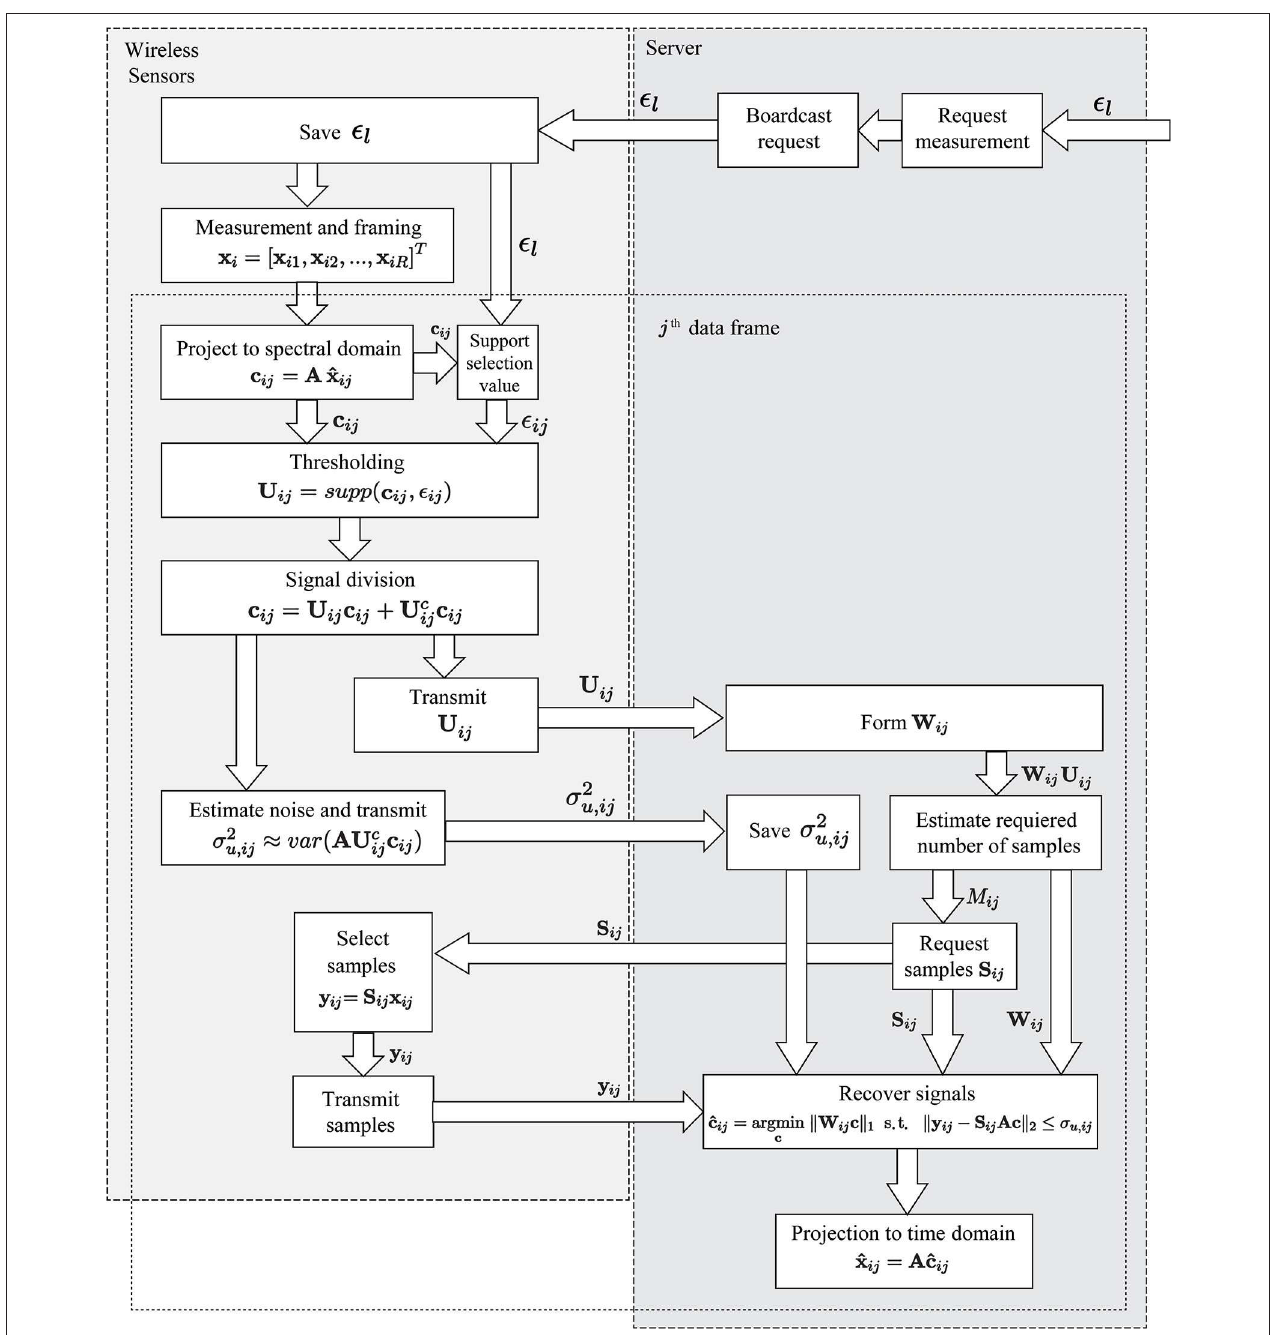
FIGURE 1 | Flowchart of spectro-temporal compressive sensing framework (Klis and Chatzi, 2016b).